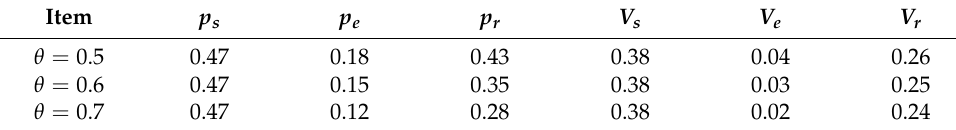
Table 5. Performance comparison under different channel strategies ( β = 0.3, p 0 = 0.8). Item